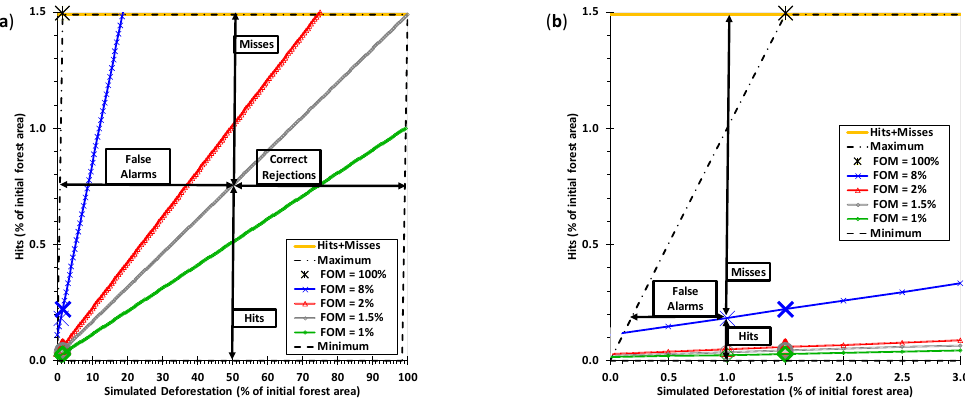
Figure 5. Lines for constant Figure of Merit in TOC space at ( a ) full range and ( b ) zoomed in.